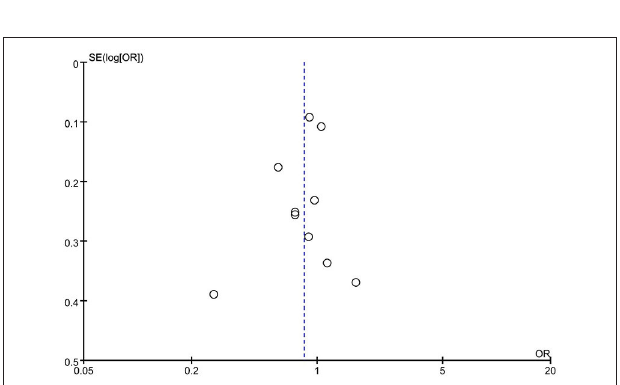
FIGURE 5 | Funnel plot of G1246A polymorphism in the HCRTR2 gene and risk of